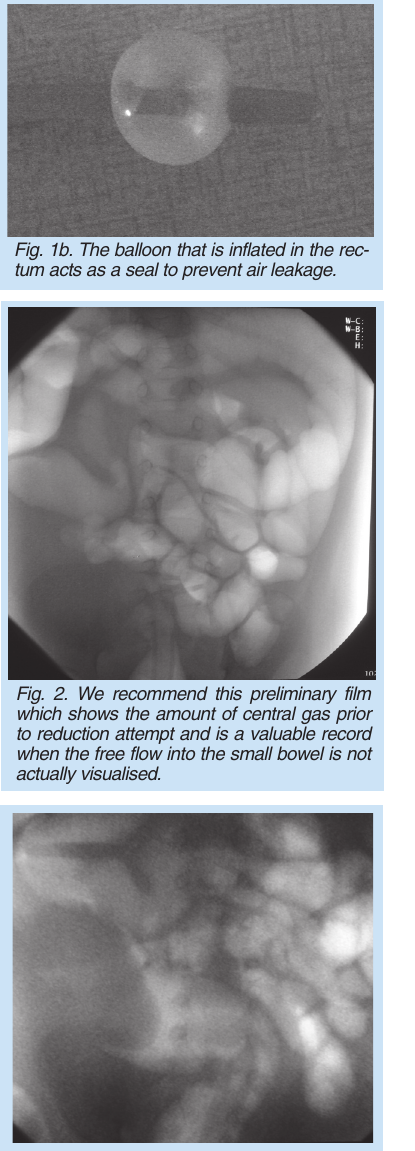
Fig. 3. An early image stored as a ‘grab’ is of low quality but is sufficient to demonstrate the intussusception being forced back by the column of air. Note that air on fluoroscopy is ‘white’ and that the sigmoid is in a ‘mirror image’ position because the procedure is performed prone by our team.